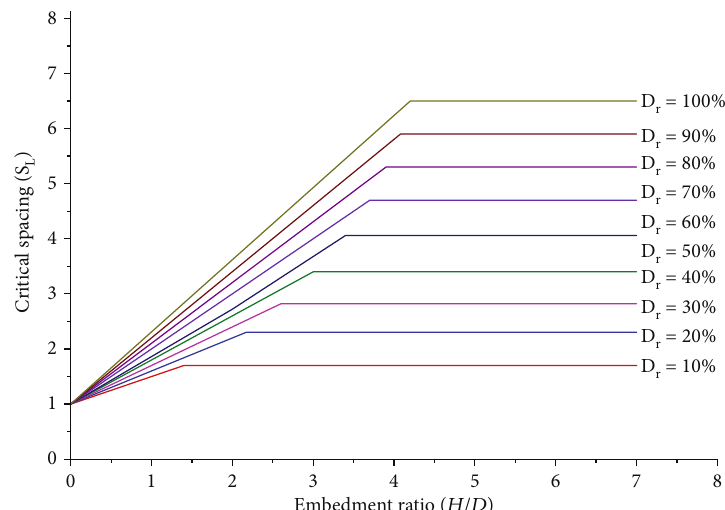
Figure 10: Fitting relationships between the critical spacing and embedment ratio.